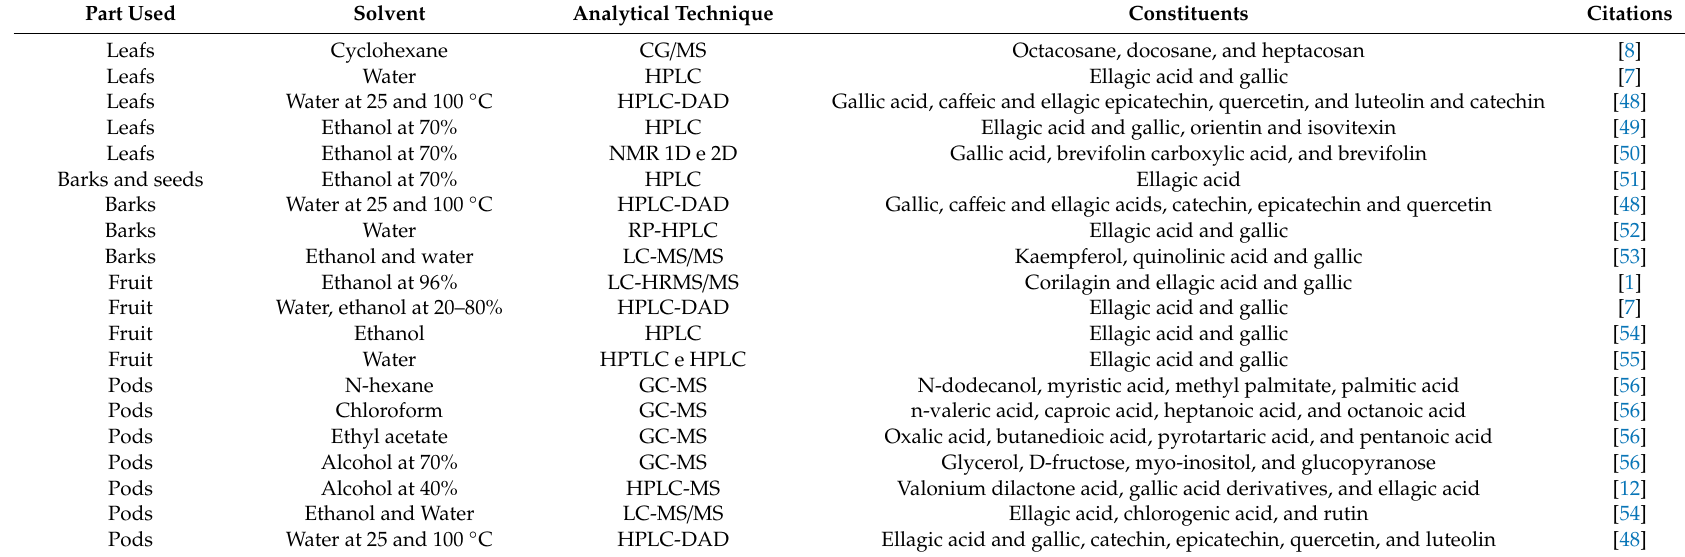
Table 3. Chemical classes or constituents found in C. ferrea